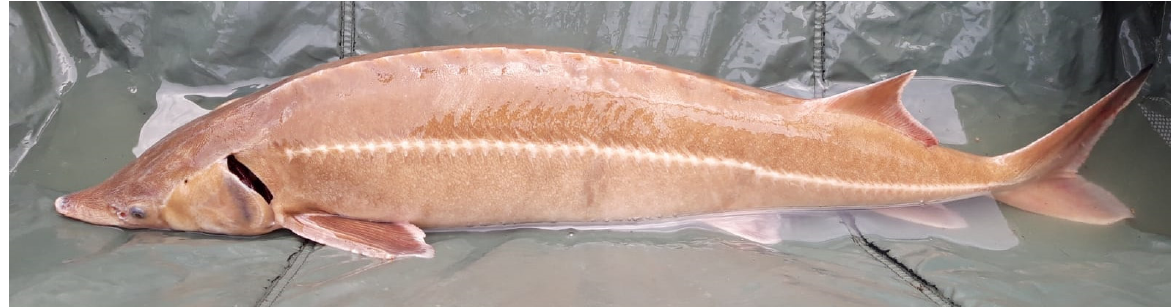
Figure 1. Large female A. ruthenus of the Freudenau remnants (TL 860 mm, weight 4900 gr).